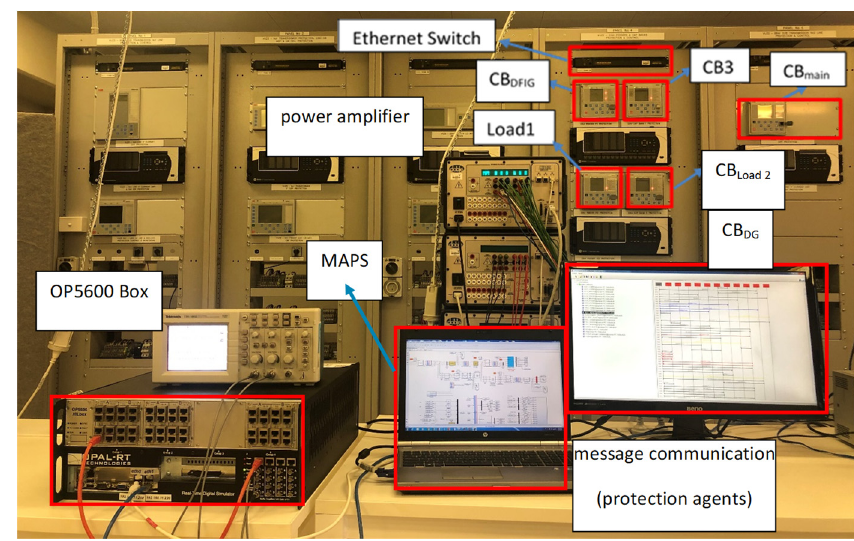
Figure 12. Architectural layers for developing co-simulation and HIL to simulate real-time MAPS.